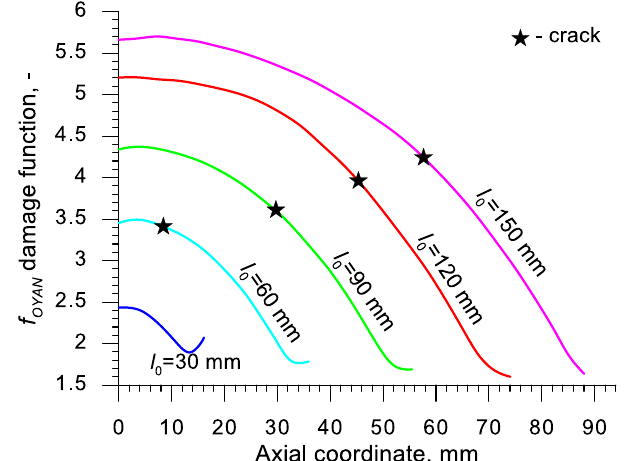
Figure 21. Distributions of the damage function in the axis of a rotationally compressed sample, determined on the basis of the Brozzo et al. criterion.